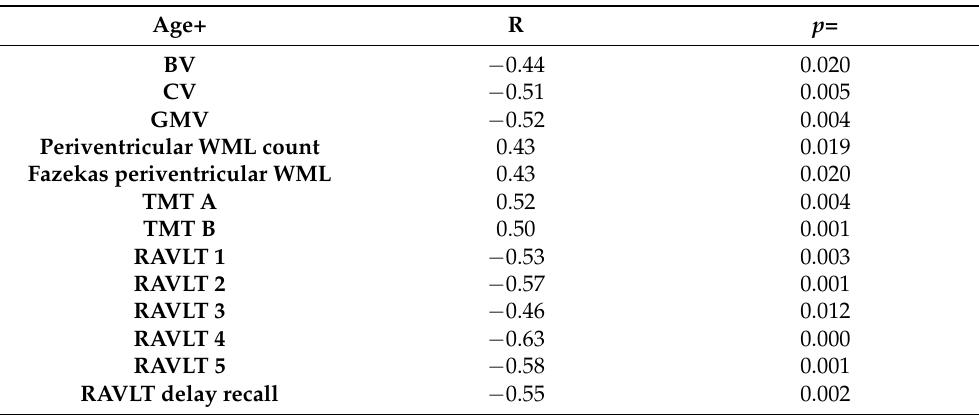
Table 3. Pearson correlation between age, severity of psoriasis and depression using the Pearson coefficient and two-sided